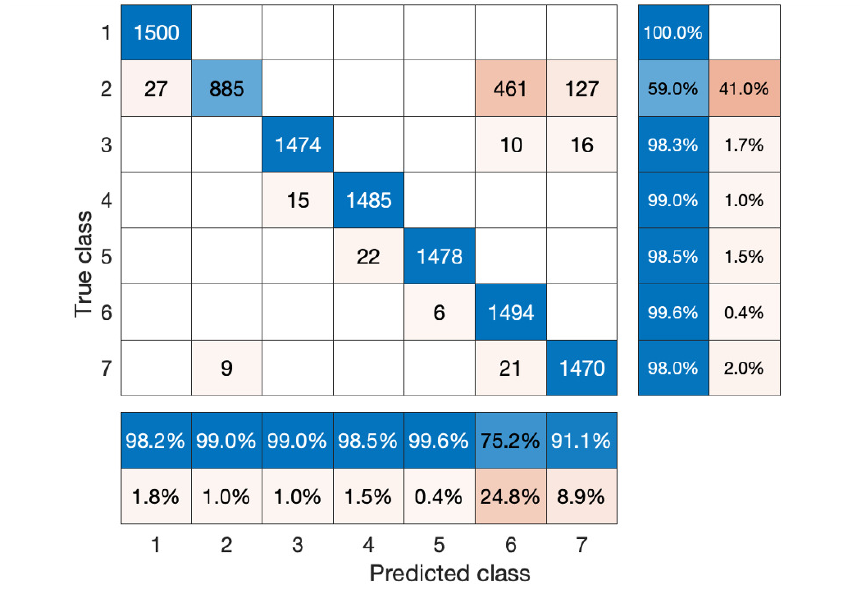
Figure 13. Confusion matrix for combining 4 sensor outputs, no. of hidden units = 50, and Σ